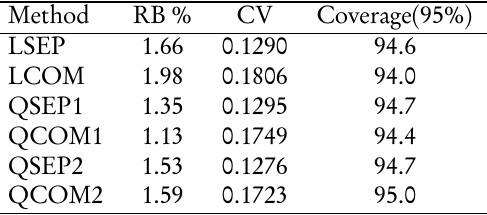
Comparison of variance estimators for (cid:210)